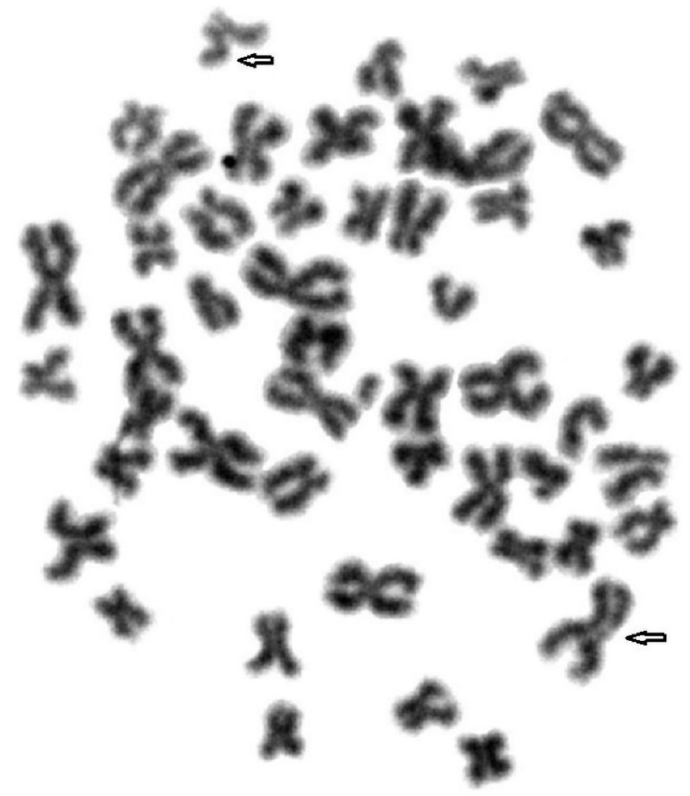
Figure 1. Fragile sites in the chromosomes of blue foxes. Damage marked with arrows.